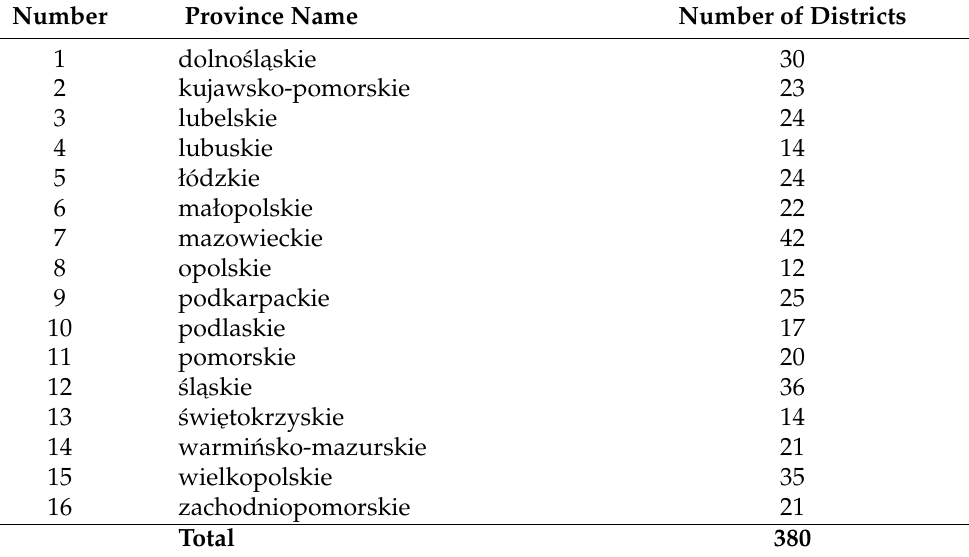
Table 2. The composition of Polish